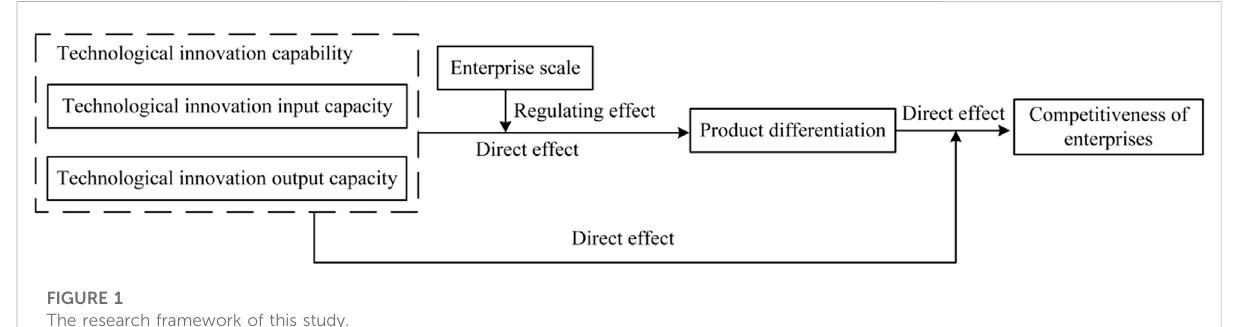
FIGURE 1 The research framework of this